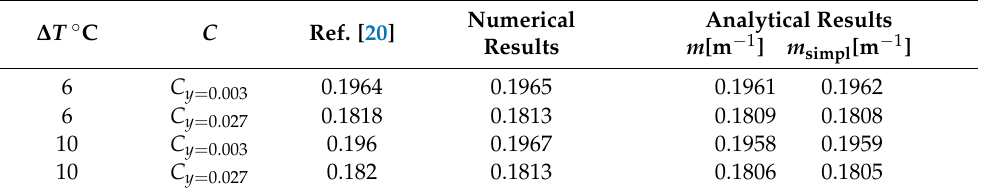
Table 2. Mass fraction values, C ( x = 0.25 mm, y = ( 3, 27 ) mm ) , obtained at the steady state, in the vertical TGC with toluene–methanol mixtures, for T h = 26 ◦ C, T c = 20 ◦ C and for T h = 28 ◦ C, T c = 18 ◦ C. ∆ T ◦ C C Ref.